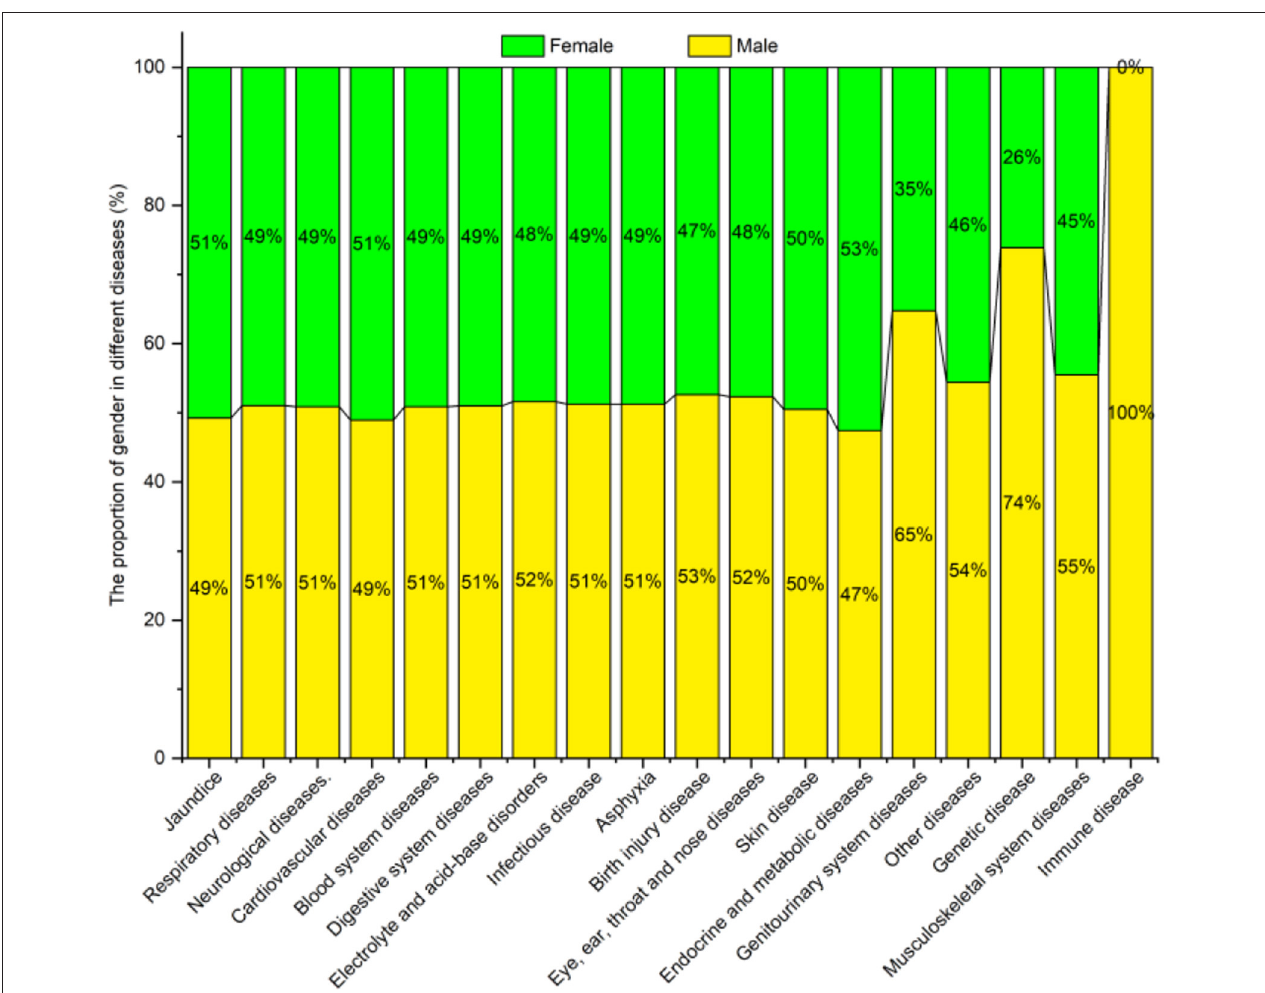
FIGURE 9 | Neonatal diseases and distribution by gender.